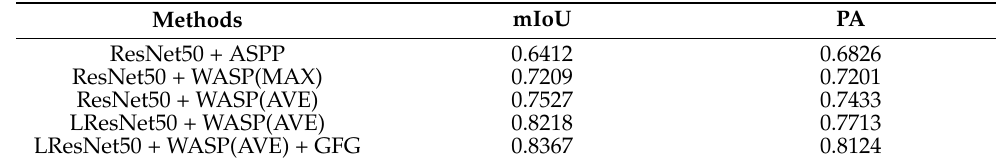
Table 5. Comparison experiments of the Semantic Segmentation module with different settings, using the Inria aerial dataset.